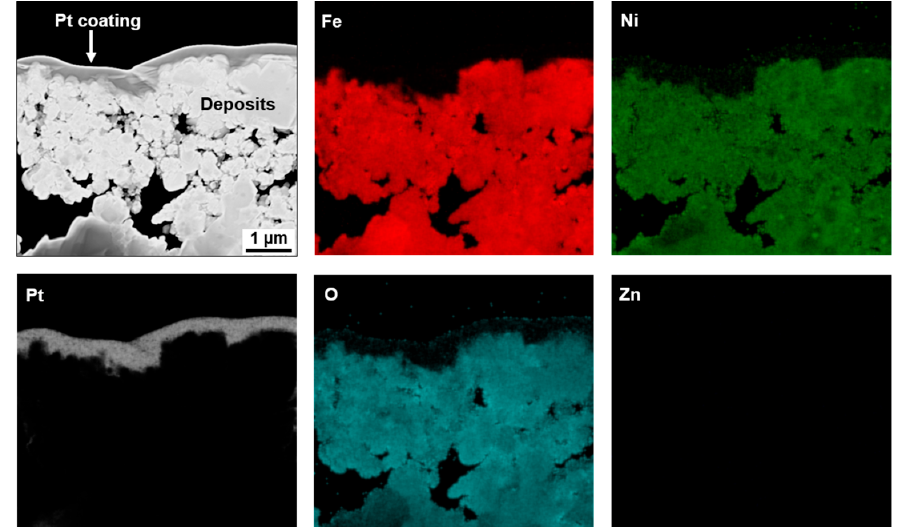
Figure 8. STEM image and EDS elemental mapping of the fuel deposits after the pre ‐ existing deposits were exposed to the 60 ppb of zinc coolant under the condition of Case #4.